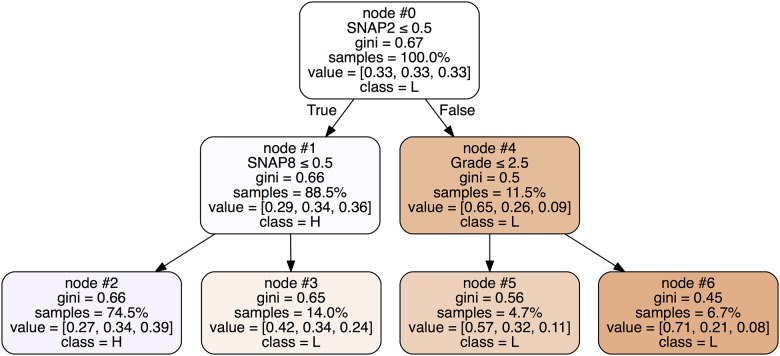
Fitted classification tree (CART analysis), including the predictor variables SNAP-IV items 1 to 9 (0 = “not true”; 1 = “somewhat true”; 2 = “certainly true”); gender (0 = girl; 1 = boy); grade (primary school class level 2, 3, 4) and the academic achievement outcome (L = low, M = medium, H = high).The percentage in each node box denote the percentage of samples routed to that particular node—where the root node will contain 100% of the samples, and a leaf node will contain the least number of samples along a rooted path in the decision tree. The node numbers are given on top of each node box. For each split decision, True denotes that the corresponding statement is true and then pointing to the left child node (that is either a new internal decision node or a final leaf node), and False denotes that the corresponding statement is false and then pointing to the right child node (that is either a new internal decision node or a final leaf node).